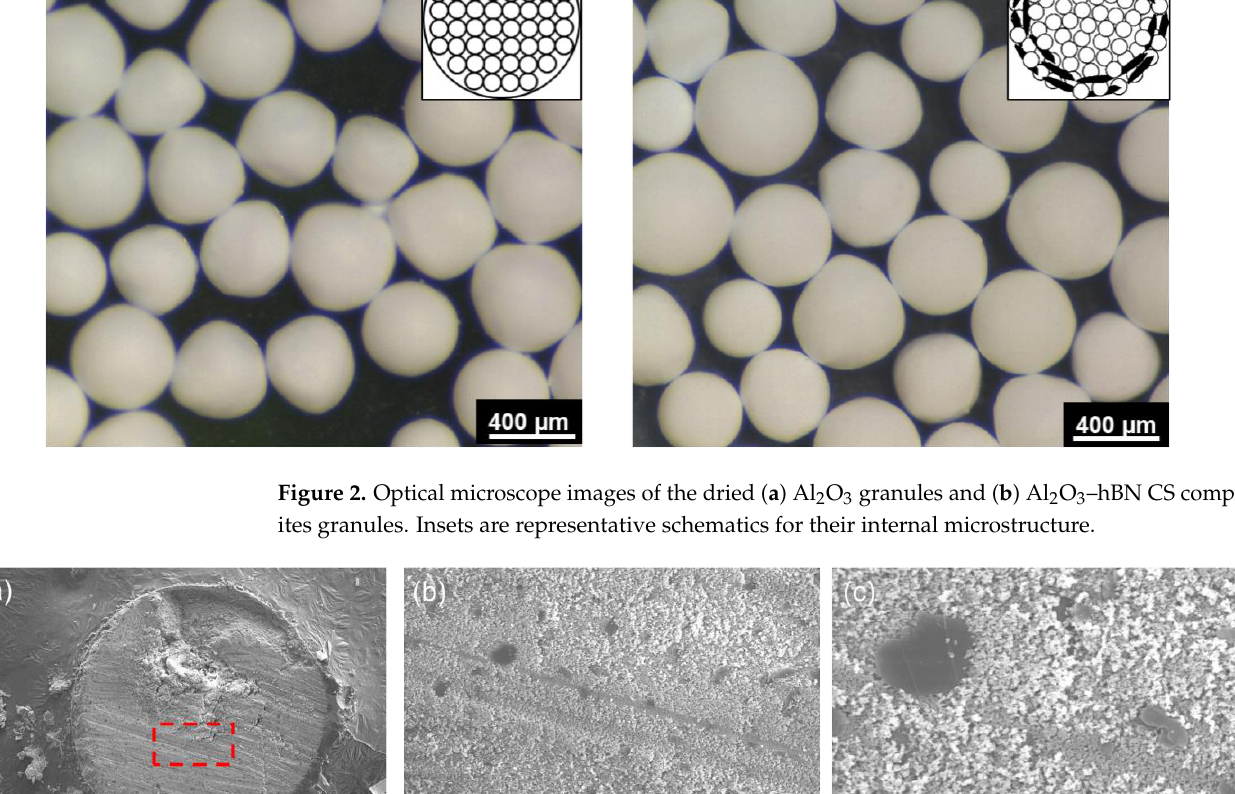
Figure 3. ( a ) Cross-sectional SEM images of a homogeneously hBN-incorporated Al 2 O 3 composite granule. ( b ) The higher magnification image of the region marked with the red-dotted line in ( a ). ( c ) Zoomed-in SEM image of an area in ( b ) indicating the presence of hBN sheets.